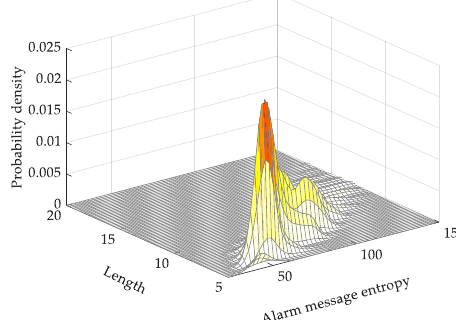
Figure 8. Probability density map of relative alarm-message entropy.